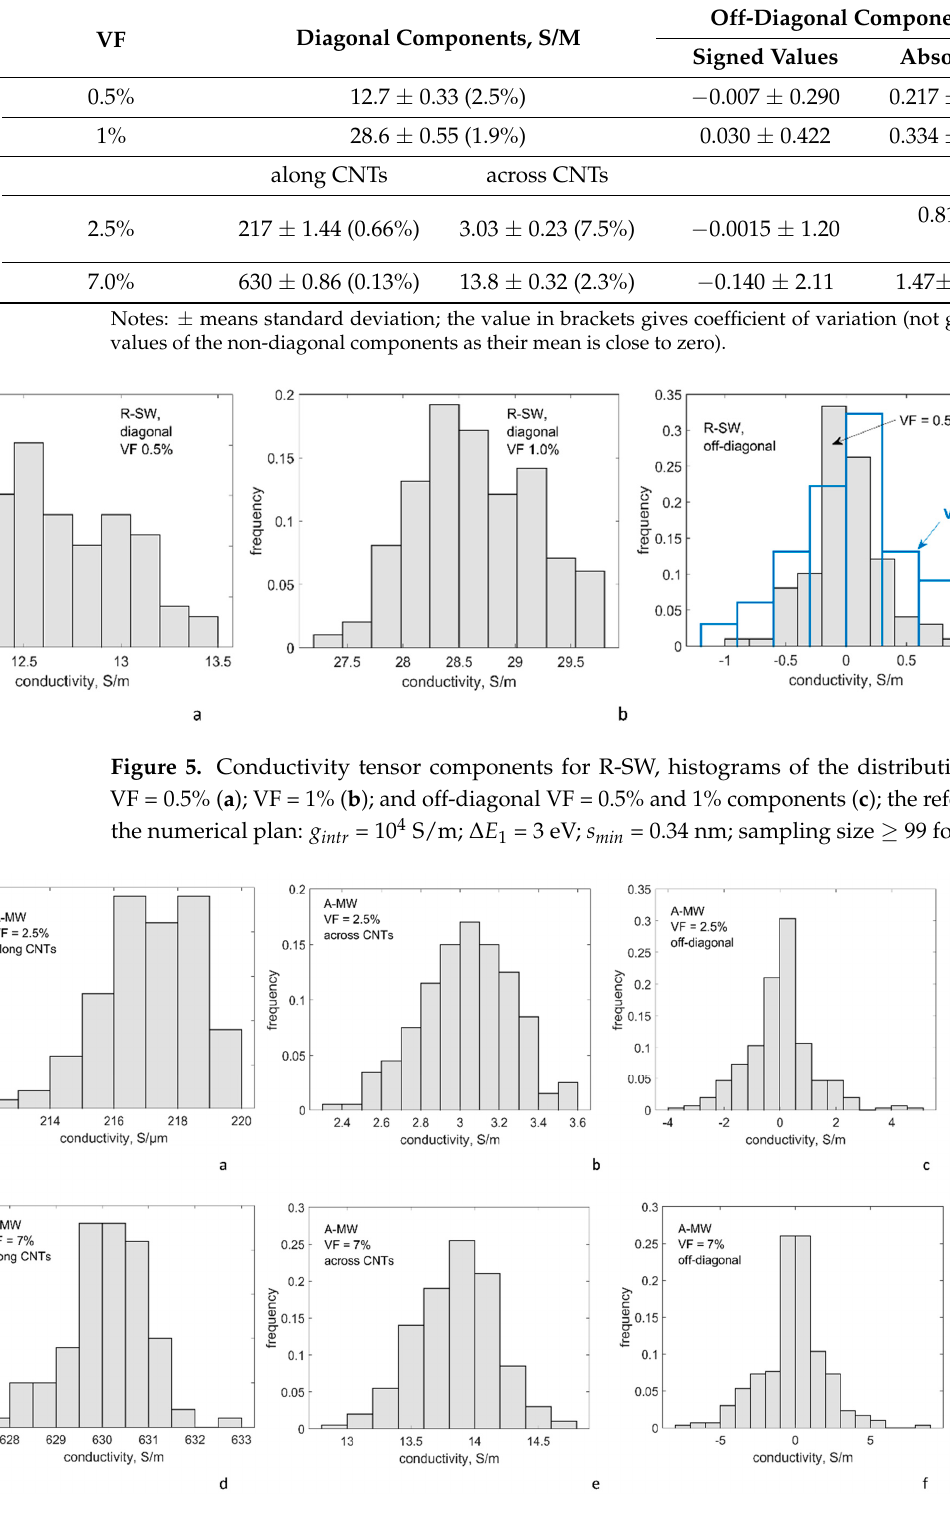
Figure 6. Conductivity tensor components for A-MW, histograms of the distributions: VF = 2.5% ( a – c ); and VF = 7% ( d – f ); conductivity along CNTs ( a , d ); across CNTs ( b , e ); and off-diagonal ( c , f ); the reference point of the numerical plan: g intr = 10 4 S/m; ∆ E 1 = 3 eV; s min = 0.34 nm; sampling size ≥ 99 for all